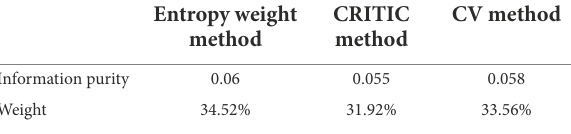
TABLE 6 Combination of 3 single methods.